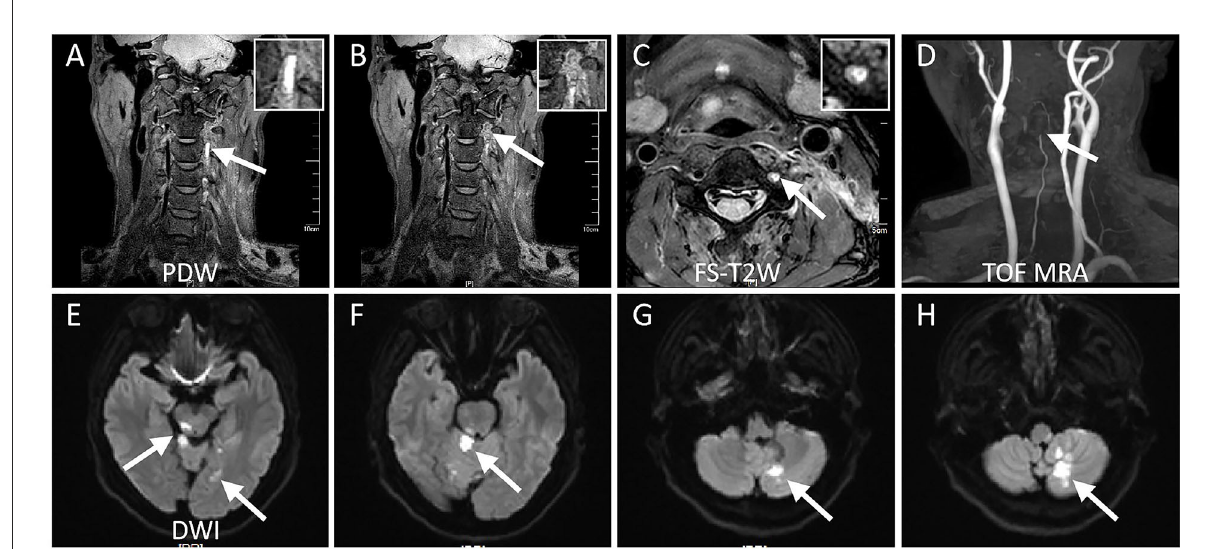
FIGURE3 Magnetic resonance imaging studies for the same case (Patient # 5). (A) 3D proton density-weighted volumetric isotropic tse acquisition (PDW) shows the homogeneous hyperintensity within the lumen suggestive of intramural hematoma. (B) PDW demonstrates intraluminal thrombus formation with heterogeneous signals downstream of intramural hematoma. (C) Fat-suppressed T 2 -weighted axial sequence clearly shows the dilated lumen of the left VA fulfilling with heterogeneous hyperintensity, which symbolizes the formation of intraluminal thrombus as a donut sign, while a normal flow void is evident on the right VA. (D) 3D time of flight magnetic resonance angiography showing the lumen of left VA tapers gradually ending in total occlusion, which is indicative of a dissection. (E–H) Diffusion-weighted imaging demonstrates multiple, scattered, acute infarcts in posterior circulation territory suggestive of artery-to-artery embolization.